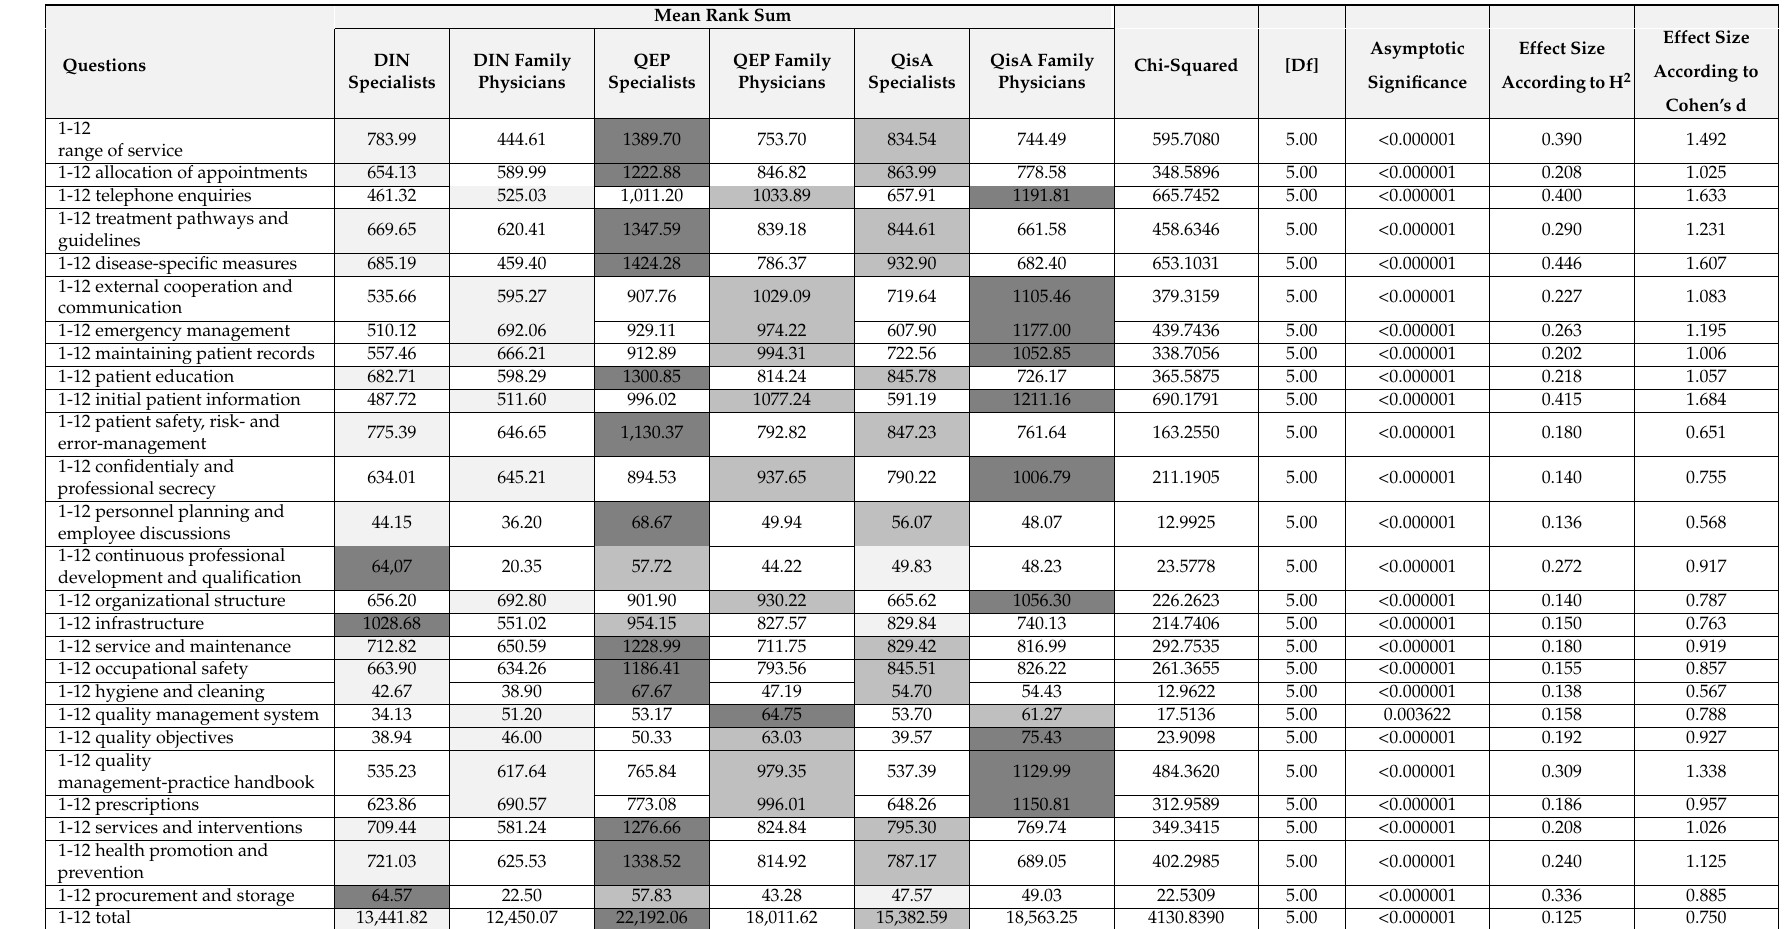
Table 3. Kruskal–Wallis